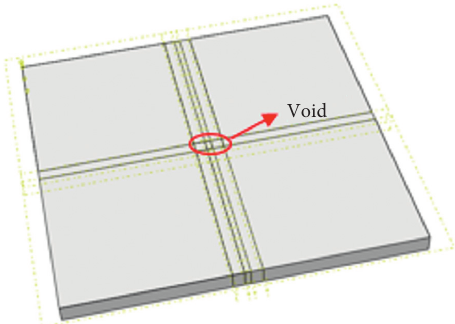
Figure 4: Layout of void area at bottom of base layer.